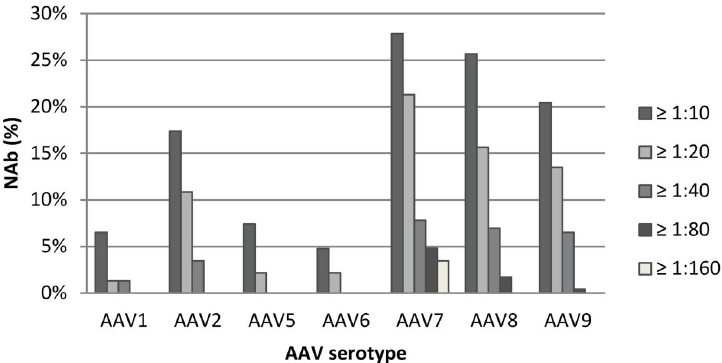
Fig 1. Prevalence of pre-existing NAb against AAV serotypes in client-owned domestic cats from Switzerland depicted according to titers. The percentage of NAb against different AAV serotypes is shown for serum dilutions of � 1:10; � 1:20, � 1:40, � 1:80 and � 1:160. NAb against AAV7, AAV8 and AAV9 were the most prevalent; NAb against AAV1, AAV5 and AAV6 were the least